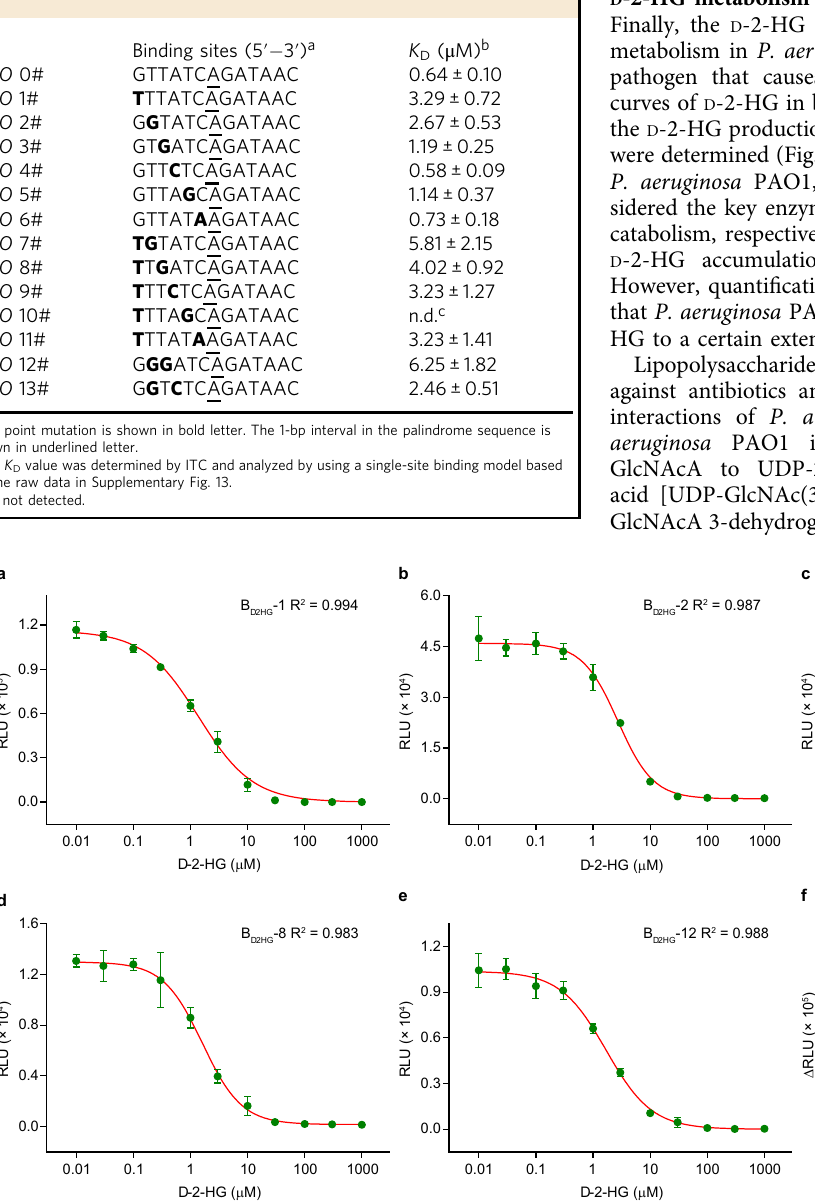
Table 1 In fl uence of point mutations in DBS on af fi nity between dhdO and DhdR.